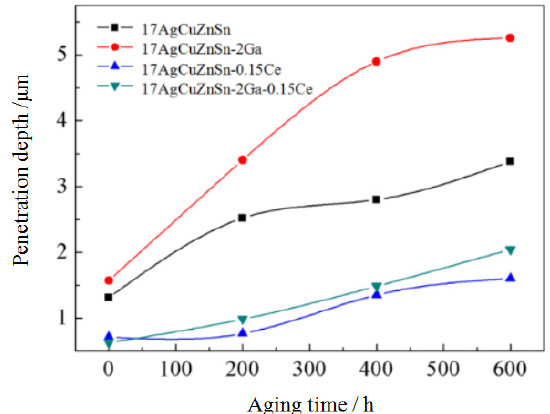
Figure 6. Effect of the aging treatment on intergranular penetration depth in the Ag16.5CuZnSn- x Ga- y Ce brazed joints.